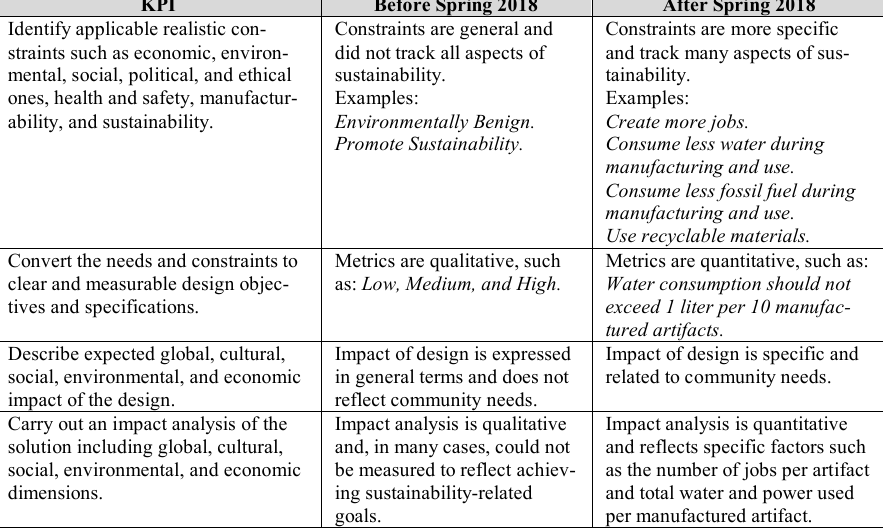
Table 3. Attainment of outcome #2 before and after introducing the concept in Spring 2018.